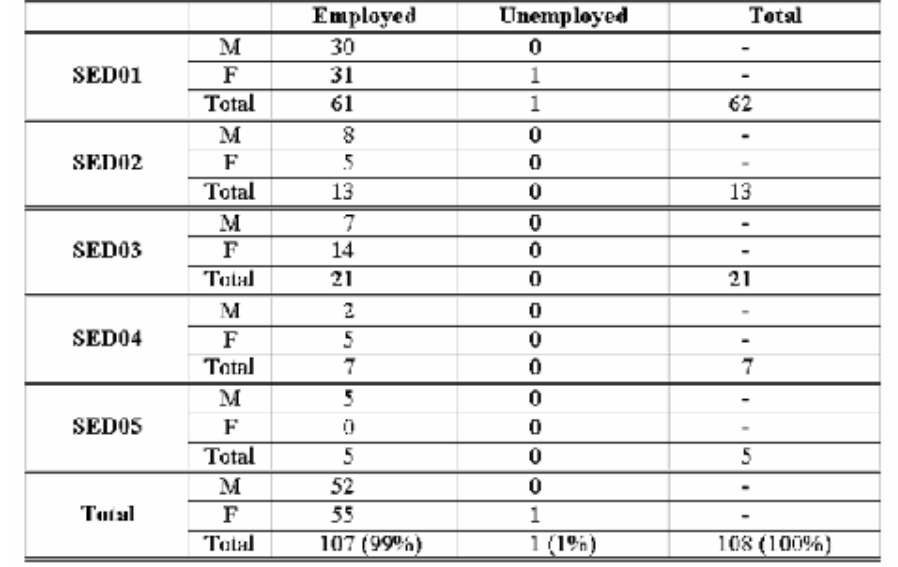
The majority of students who dropped out belonged to the 30-39 age groups, and were employed as school-teachers (see Table